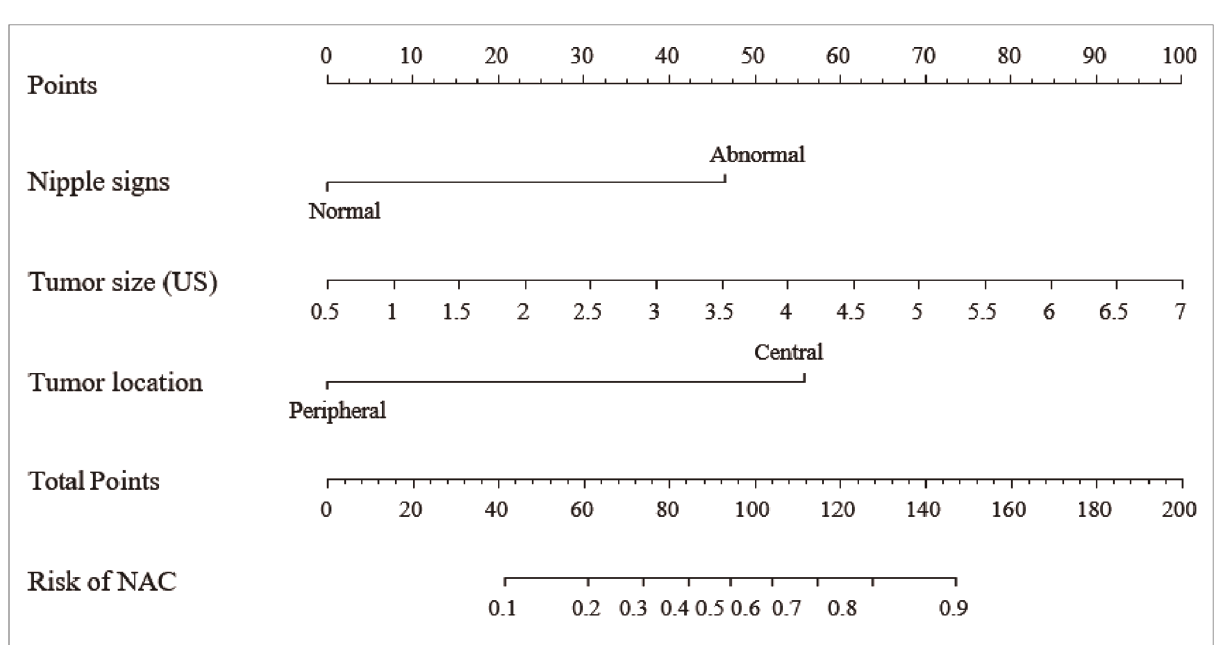
FIGURE 1 A clinical model nomogram for the prediction of NI. US, ultrasound; NI, nipple